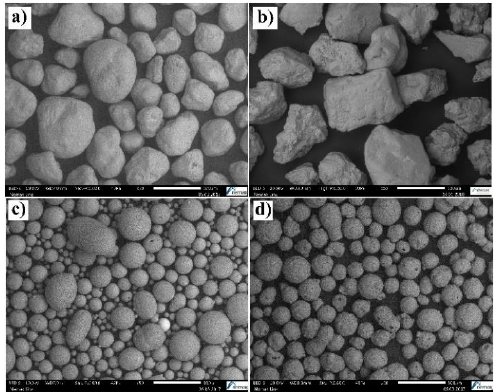
Figure 1. SEM pictures (×50) of tested sand types: ( a ) sand A; ( b ) sand B; ( c ) sand C; and ( d ) sand D.